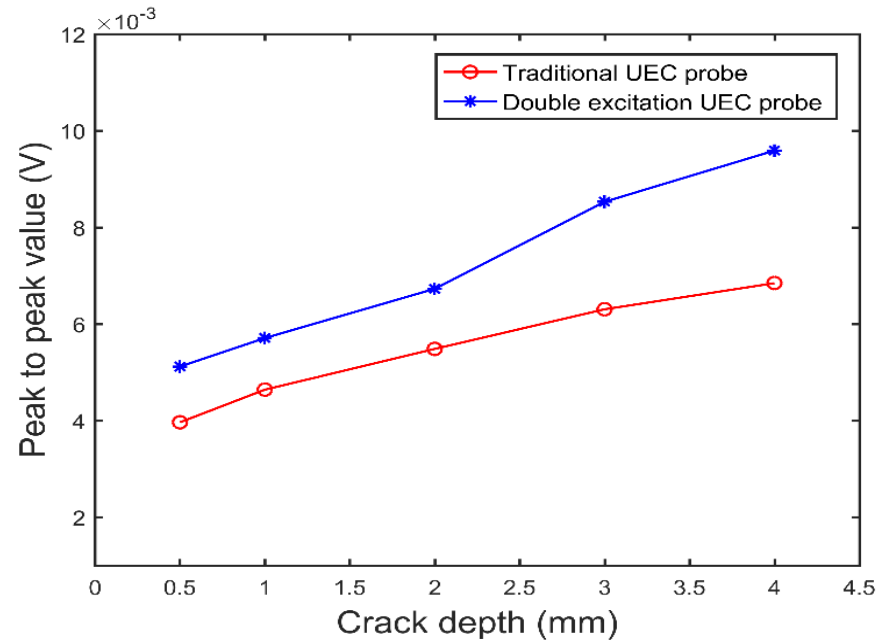
Figure 9. The peak to peak value of the test signal of the two UEC probes as a function of crack defect depth. defect